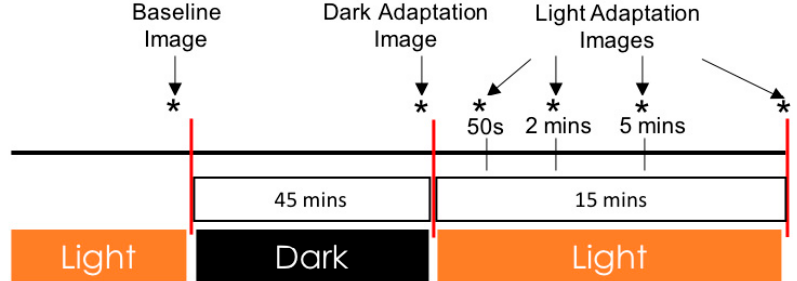
Figure 1. Schematic of dark and light adaptation image acquisition. Images were acquired at baseline in ambient light, after 45 min of dark adaptation, and at several time points (50 s, 2 min, 5 min, and 15 min) after transitioning from dark to ambient light. An asterisk (*) denotes a timepoint of optical coherence tomography angiography (OCTA) image acquisition.